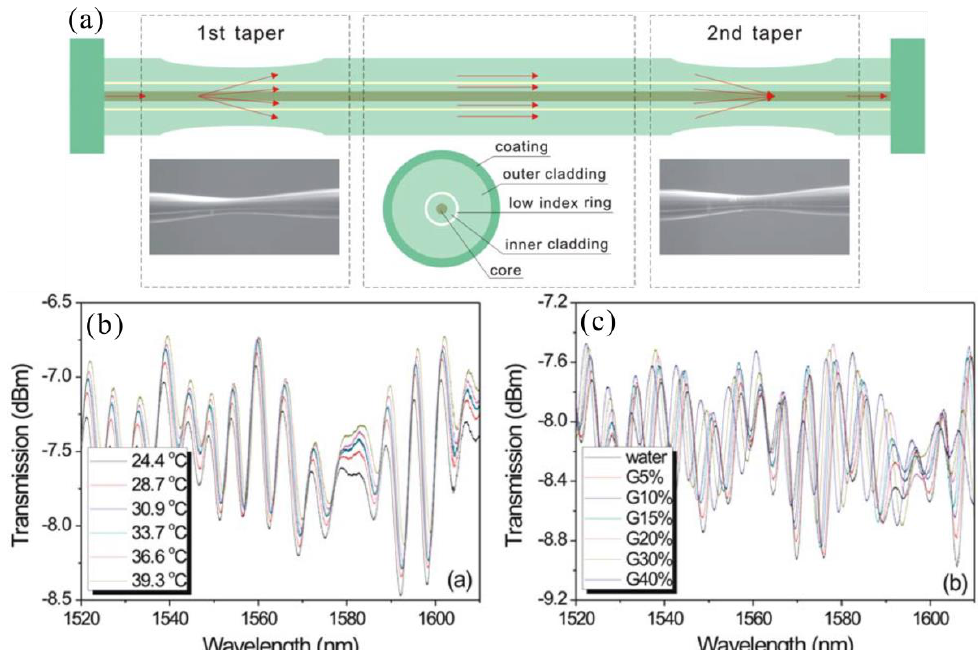
Figure 2. ( a ) Schematic illustration of the tapered bend-insensitive fiber interferometer; Shift in the transmission spectrum with a change in ( b ) ambient temperature and ( c ) external RI [45].